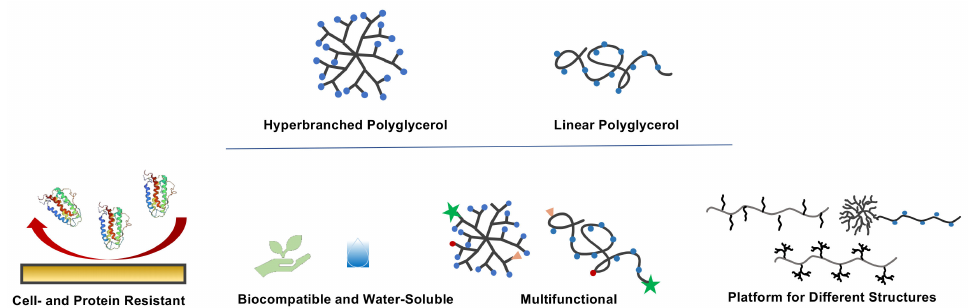
Figure 9. Properties of polyglycerols make them suitable candidates for biomedical